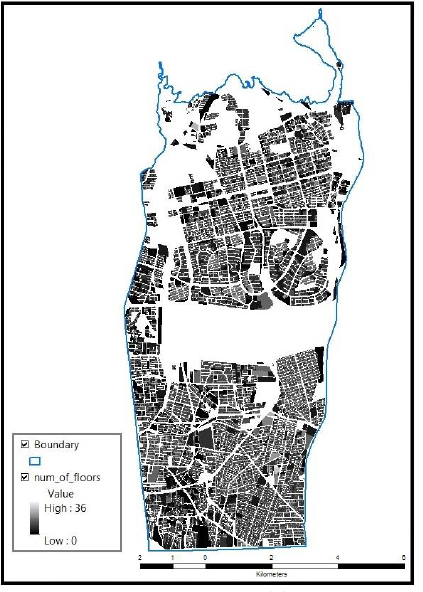
Figure 2. Distance to fault  Peak ground acceleration layer: Peak Ground Acceleration (PGA) is equal to the maximum ground acceleration that occurs during earthquake shaking at a location. According to the data obtained from Iran Strong Motion (Road, Housing & Urban Development Research Center) PGA varies from 0.21g to 0.34g in the study area (Figure 3). The higher the PGA value, the greater the probability of damage.